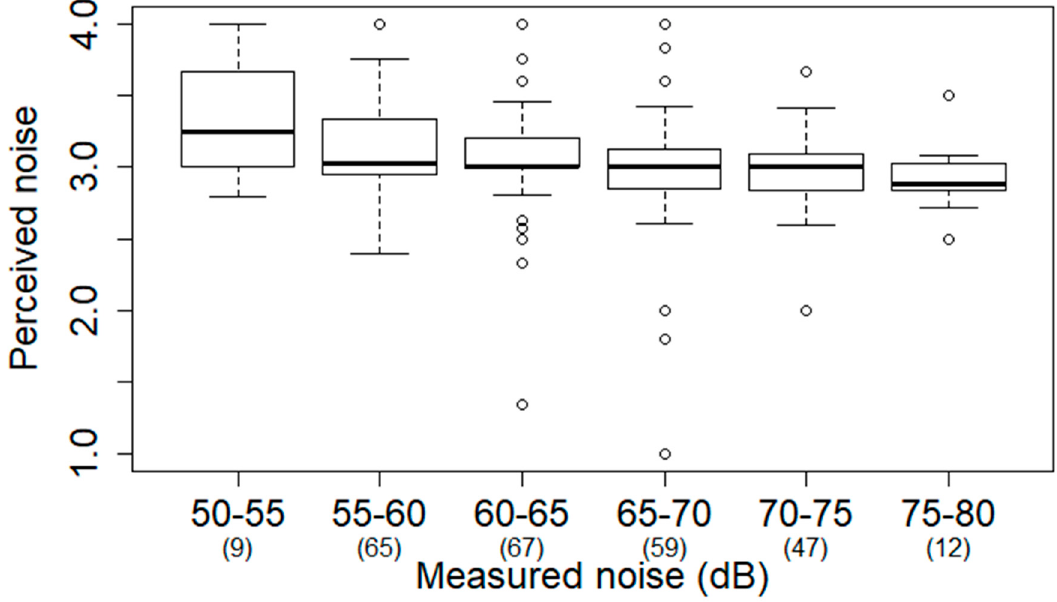
Figure 3. Perceived noise (scale of 1–4 where 1 is extremely serious, 2 is serious, 3 is not serious, and 4 is not serious at all) within 500 m of noise monitoring stations increased with measured noise. The numbers of stations in each measured noise category are shown in parentheses.